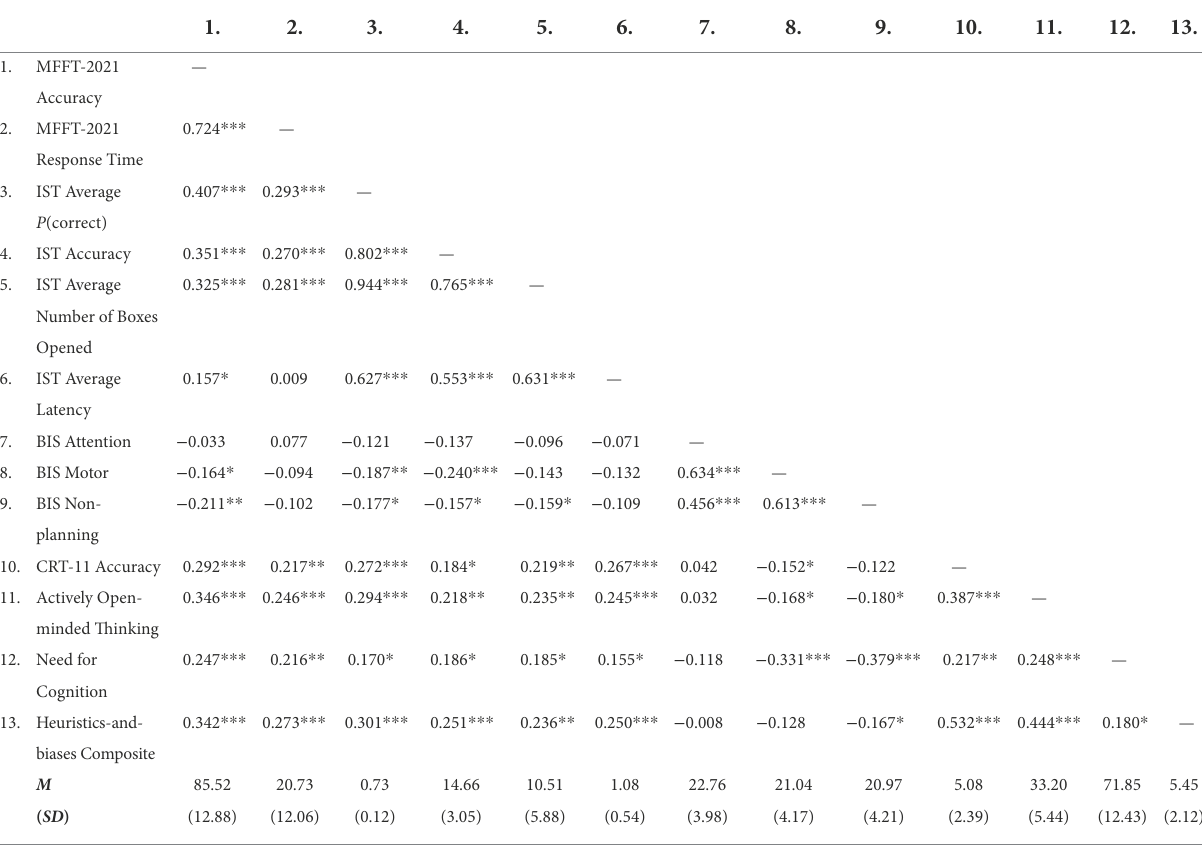
TABLE 6 Study 2 Means, SDs, and zero-order correlations.